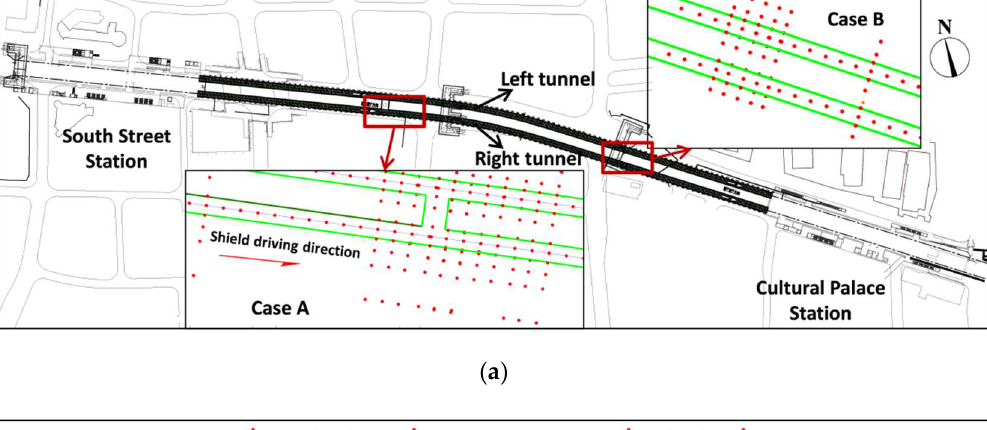
Table 1. Input parameters for displacement calculation.